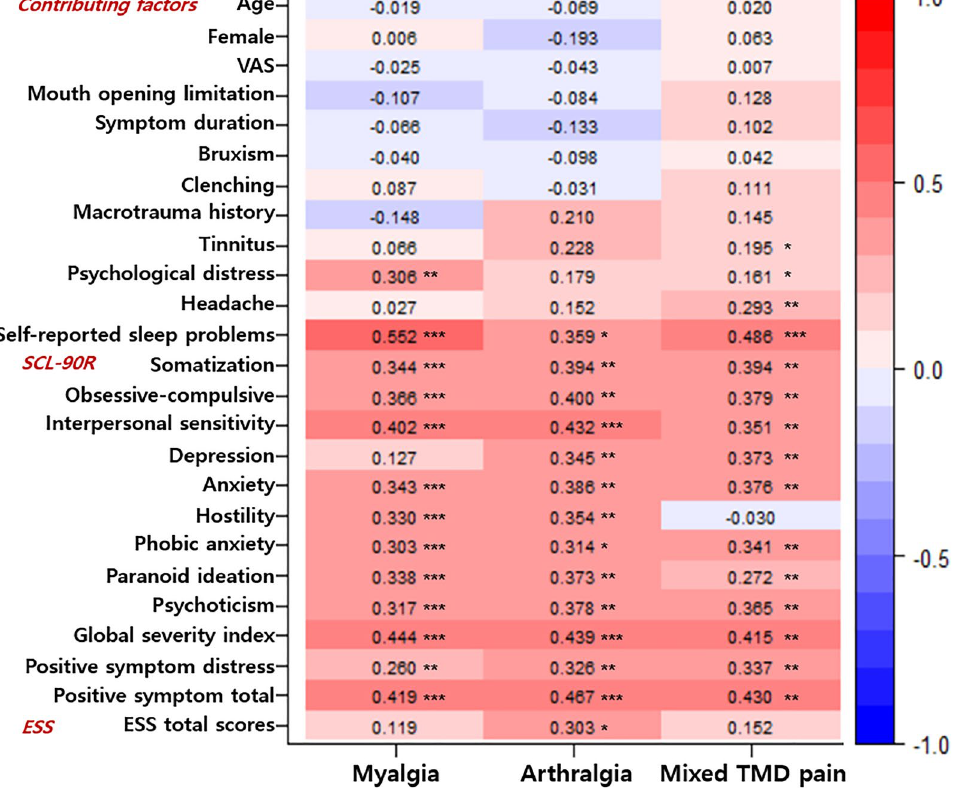
Figure 1. Correlations of PSQI global scores with clinical characteristics and contributing factors for TMD. P-value was considered as significant when p-value < 0.05 (*: p < 0.05, **: p < 0.01, ***: p <